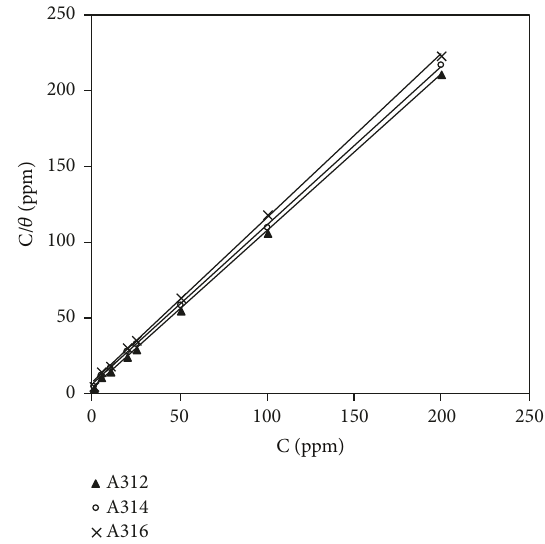
Figure 6: Langmuir isotherm plots for API X52 steel in 1M HCl at presence of different concentrations of synthesized corrosion inhibitors A312, A314, and